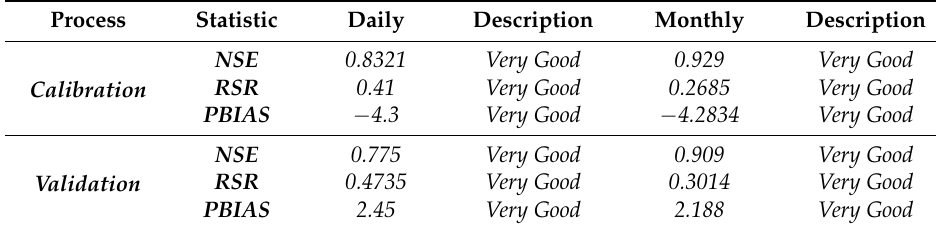
Table 4. Results of the statistical indicators that evaluate the performance of the calibration and validation of the distributed hydrological model, calculated from daily and mean monthly time series, in La Antigua River basin.